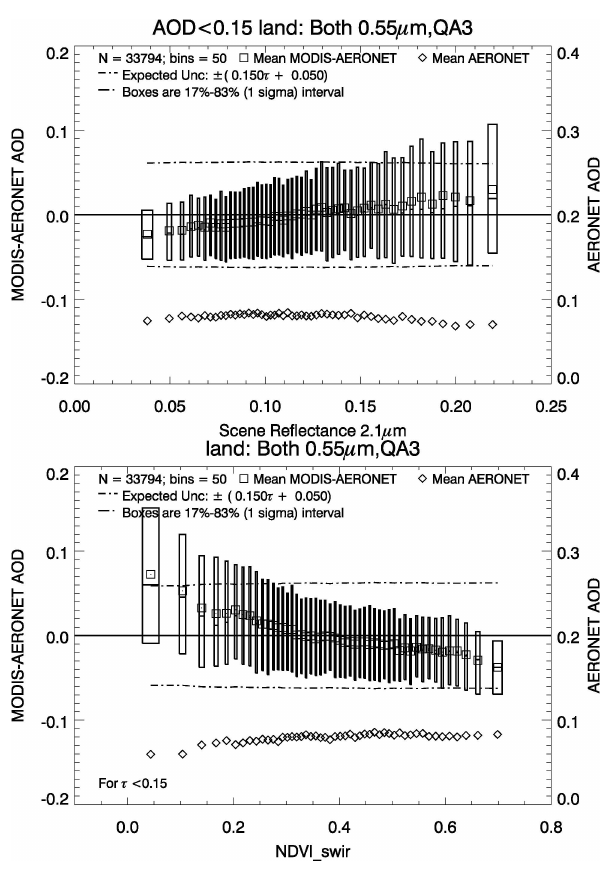
Fig. 9. Differences between MODIS and AERONET-reported AOD at 0.55µm (MODIS-AERONET) for “light” ( τ < 0.15) load- ing cases with QAC=3. Plotted are the differences compared to 2.1µm scene reflectance (top) and to NDVI swir (bottom). Expla- nation of symbols is same as for Fig.